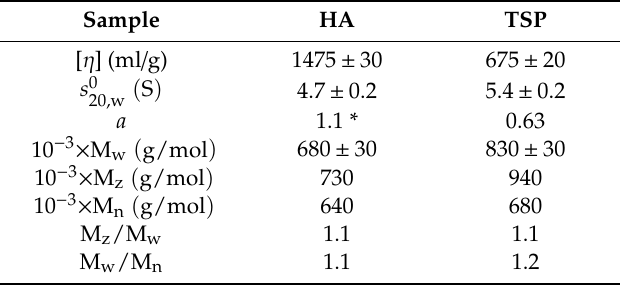
Table 1. Hydrodynamic properties of hyaluronic acid (HA) and tamarind seed gum polysaccharide (TSP) in PBS “Paley” bu ff